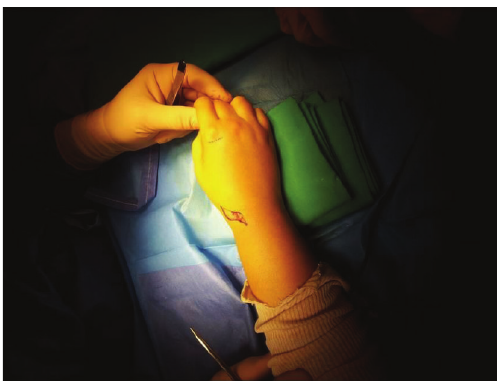
Figure 1: Clinical examination shows a thumb in flexion position.